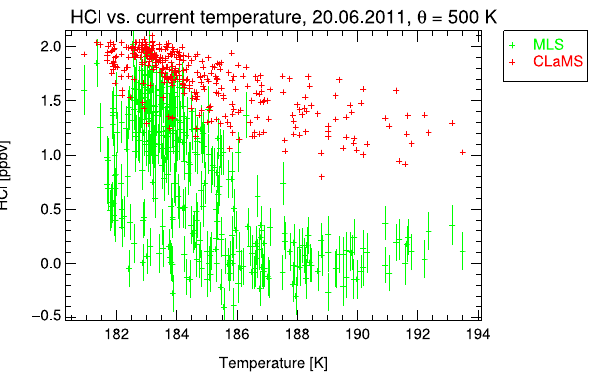
Figure 7. MLS observations of HCl mixing ratio on 20 June 2011 in the vortex core ( (cid:56) e > 75 ◦ S) on the 500K potential temperature level. The individual data points are plotted as a function of temper- ature given by ERA-Interim (green symbols). The error bars show the given measurement precision. The corresponding CLaMS re- sults are given as red